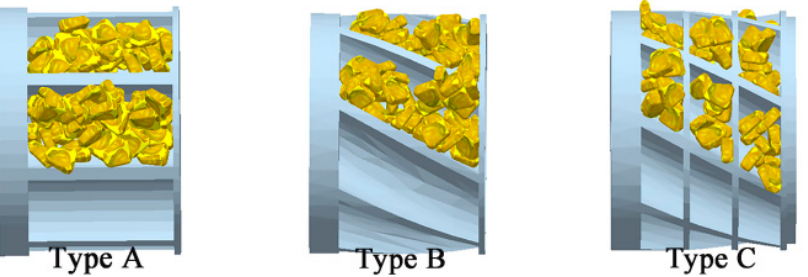
Figure 2. Structure schematic diagram of feeding wheel. Type A is a straight groove-type seed wheel, Type B is a spiral groove-type seed wheel, and Type C is a grid groove-type seed wheel .